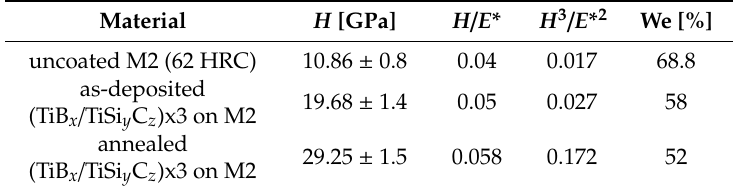
Table 2. Mechanical properties of the M2 steel coated by (TiB x / TiSi y C z )x3 multilayer in as-deposited state and after short annealing with respect to the uncoated M2